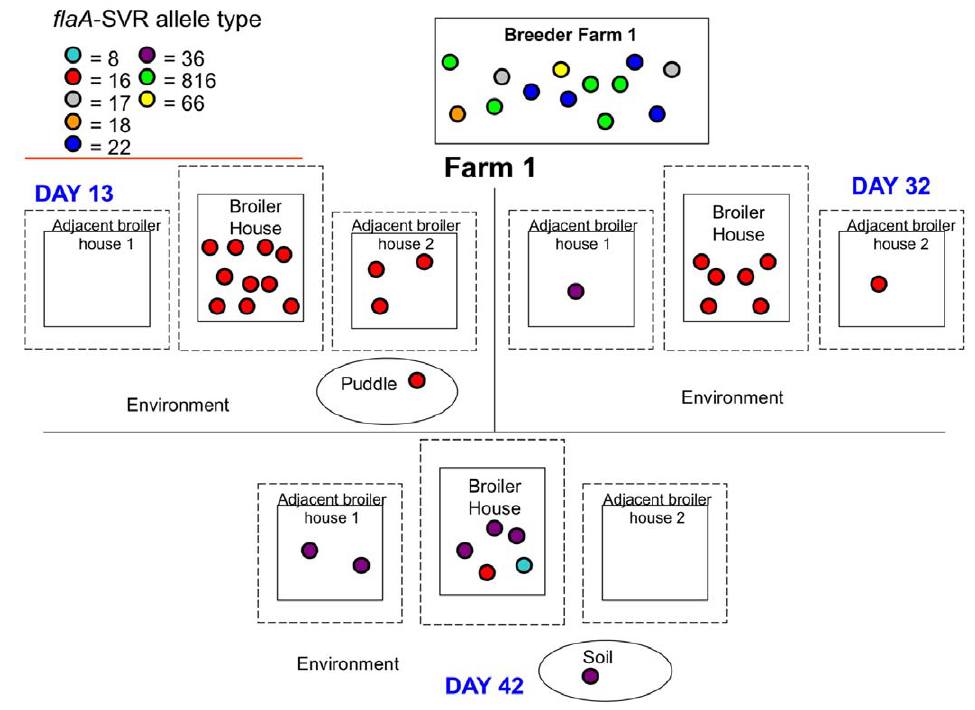
Figure 2. Schematic diagram of the flaA -SVR alleles detected on farm 1.